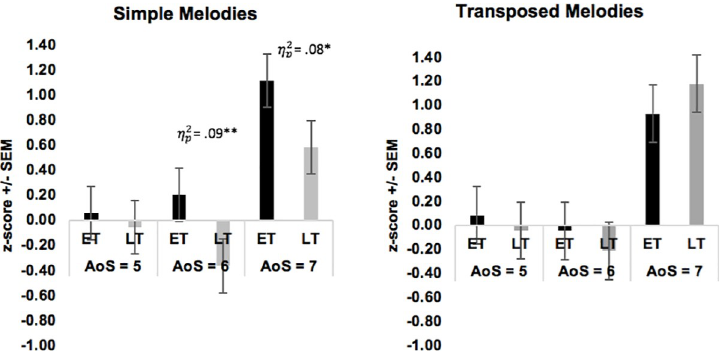
Fig 5. Results of one-way ANOVA for children’s Melody Discrimination Task (c-MDT). Bars represent early- trained (ET) and late-trained (LT) musicians at three age of start cut-offs. Performance is measured as age-based z- scores for Simple Melodies (L) and Transposed Melodies